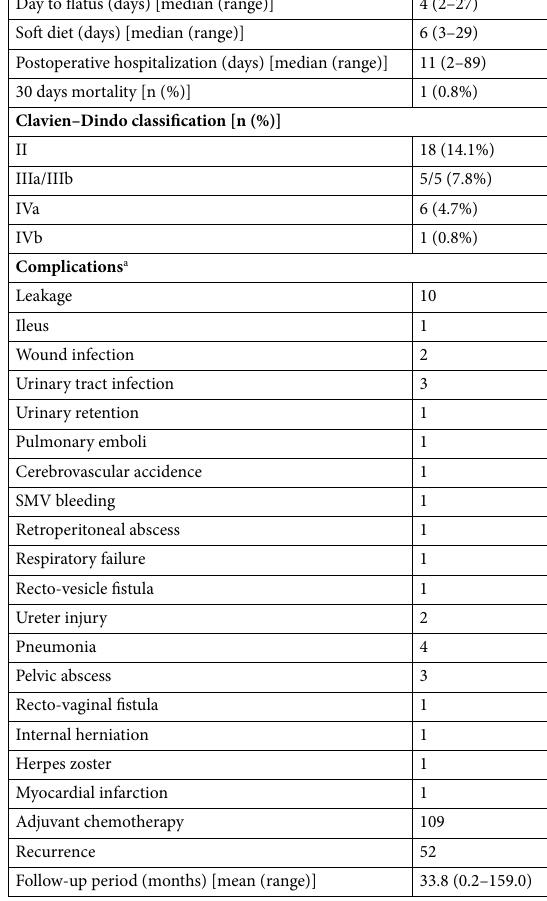
Table 5. Surgical outcomes of patients. a A patient may have more than 1 type of